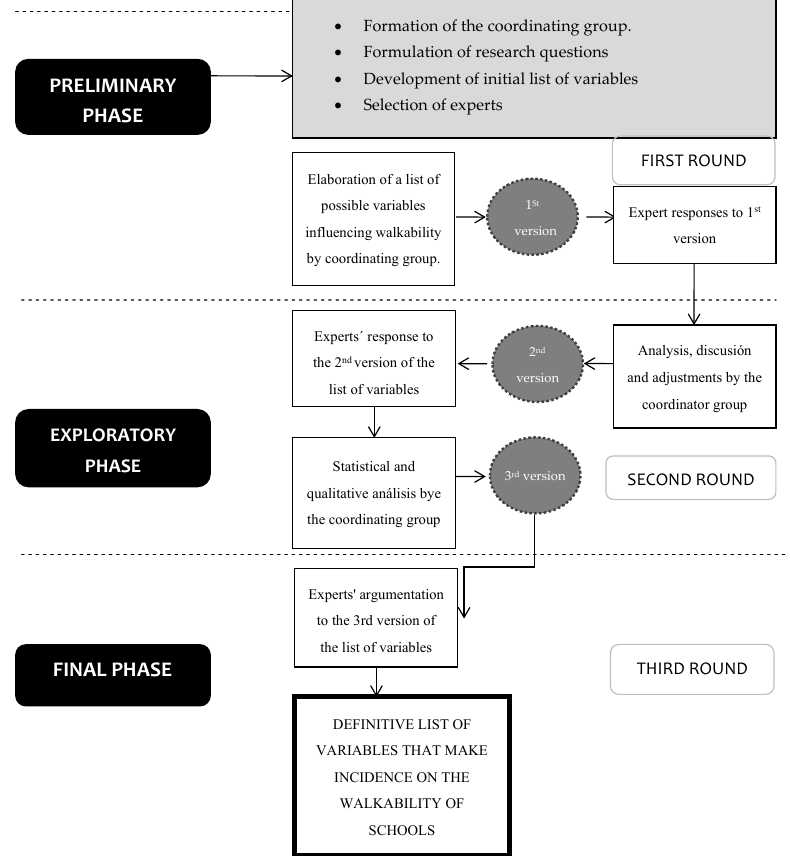
Figure 1. Delphi method description.